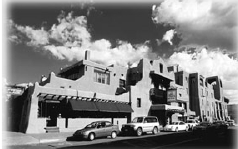
Figure 2: Santa Fe's historic La Fonda was built in 1922 and is known for its award-win- ning Spanish pueblo